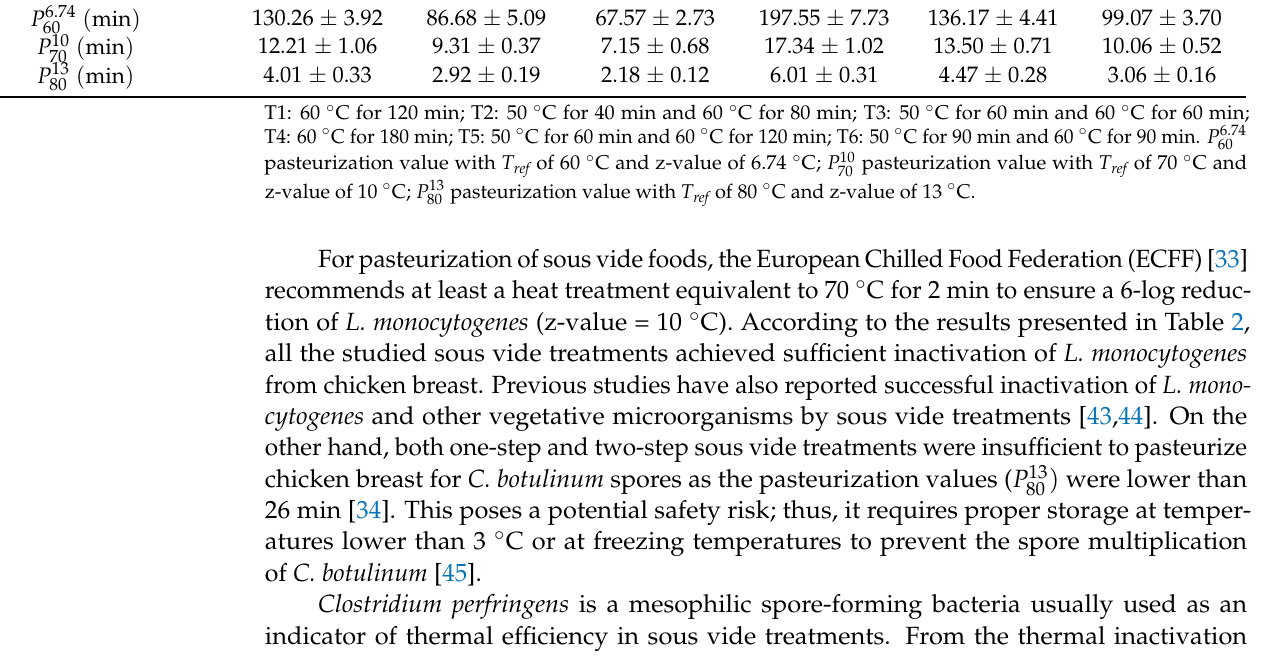
, P 10 , P 13 ) of chicken breast 60 70 80